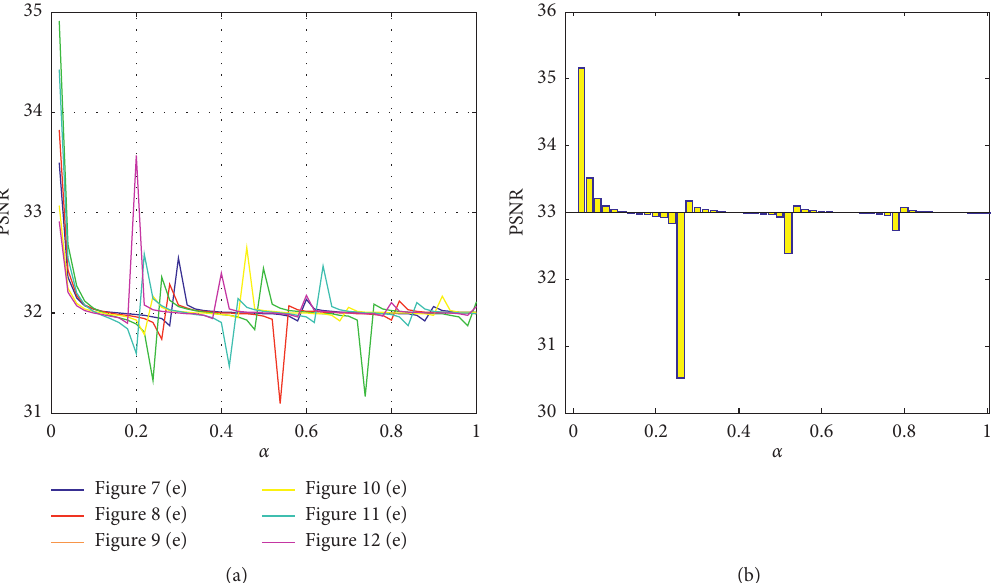
Figure 14: PSNR diagram of repair results under different α values. (a) PSNR when α takes different values. (b) Average PSNR when α takes different values.